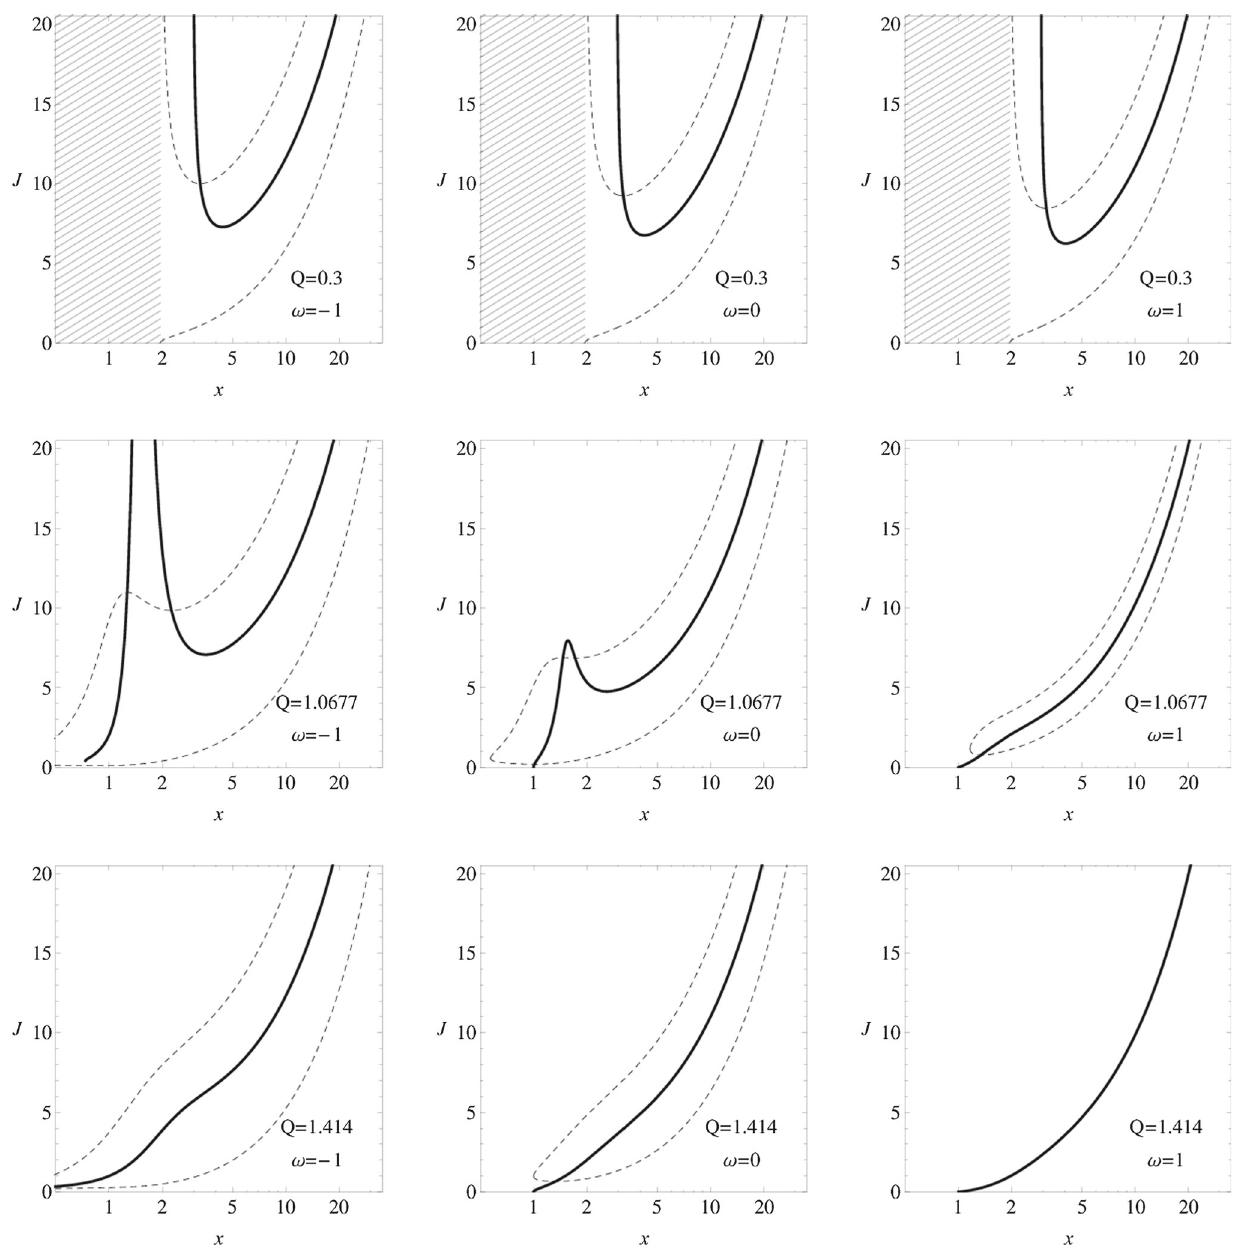
Fig. 4 The behavior of string loop’s angular momentum parameter corresponding to effective potential’s equatorial extreme (thick black) along with angular momentum parameters J L1 and J L2 defining the